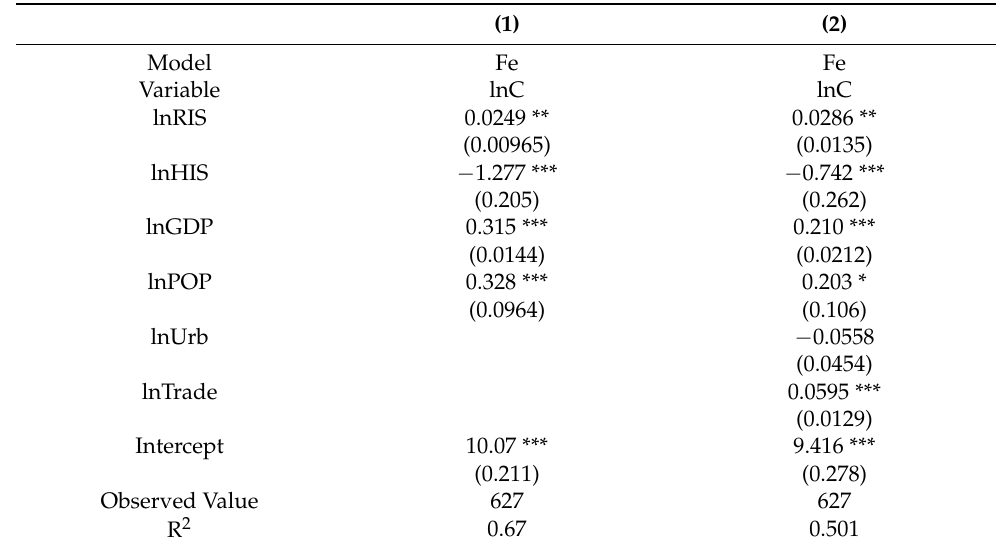
Table 3. Results of benchmark regression